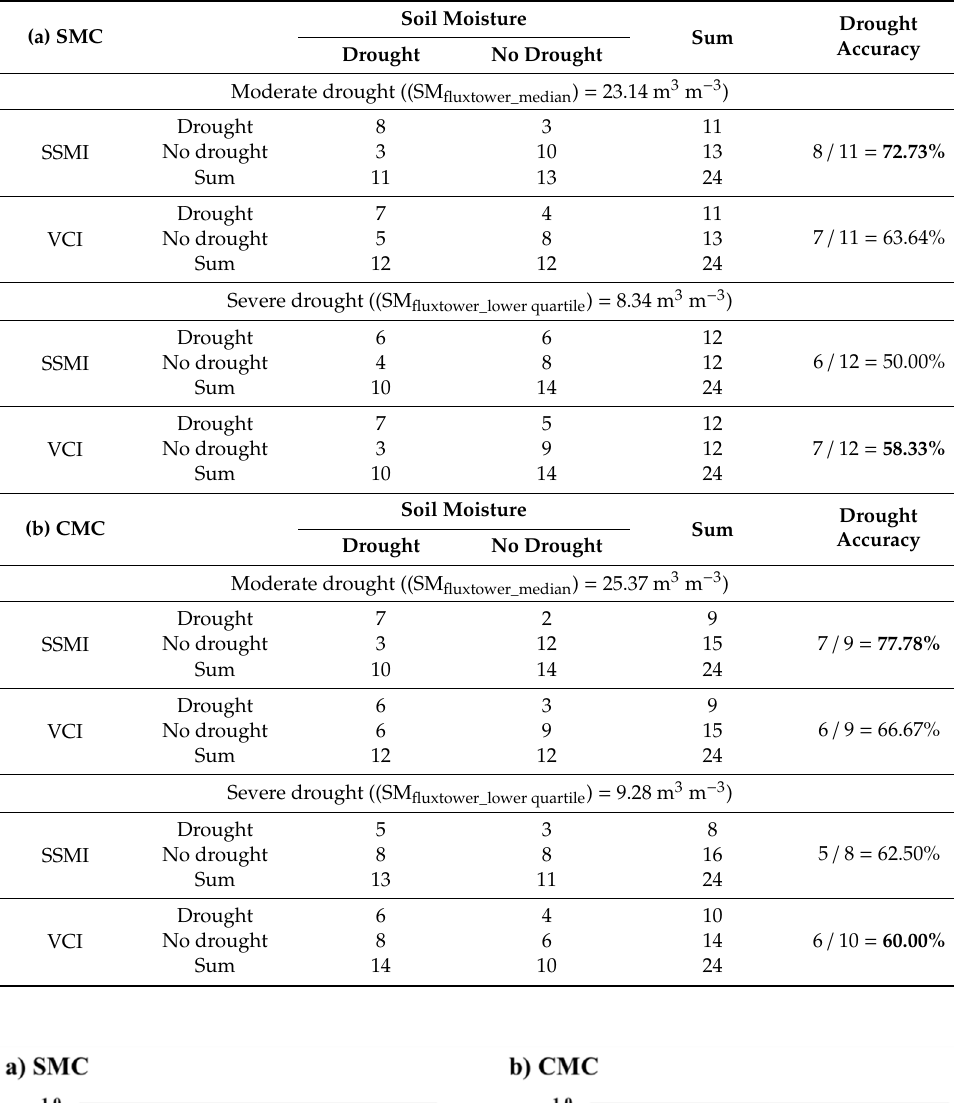
Table 5. Error analysis for the study area.